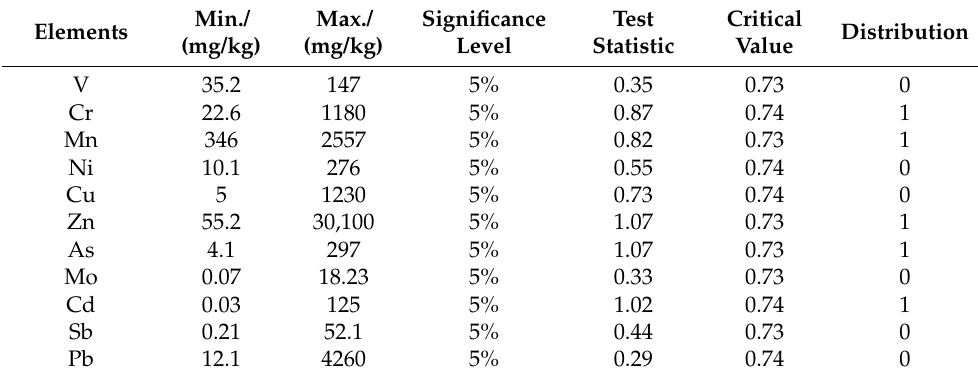
Table 5. The elemental concentration ranges and Anderson–Darling